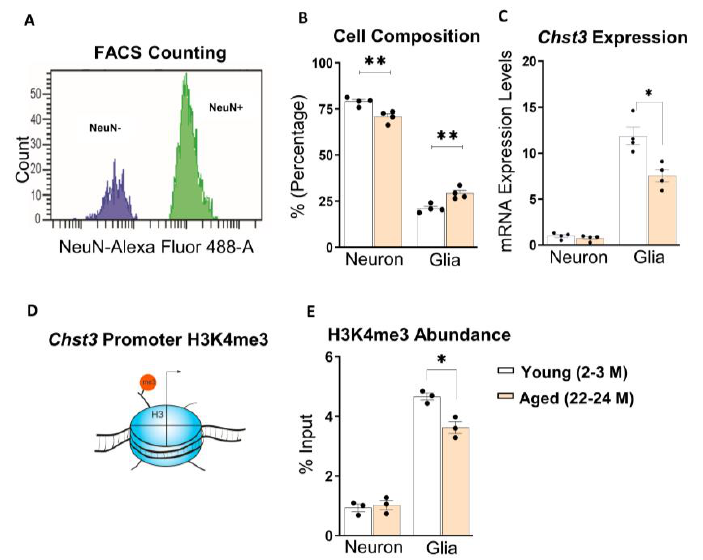
Figure 5. H3K4me3 is mostly enriched at the glial Chst3 promoter in the hippocampus of 22-24 M-old mice. Changes in Chst3 gene expression during aging were investigated specifically at the Chst3 promoter in NeuN − positive and negative cells, which corresponds to neuronal and glial cells, respectively, in the hippocampus of 22-24 M-old mice and 2-3 M-old mice. ( A ) Representative neuronal and glial nuclei amounts were quantified and the cell composition for each study group was determined using FACS techniques with neuron-specific NeuN-antibody conjugated to Alexa Flour 488. ( B ) Thus, percentages of neurons and non-neuronal cells (predominantly glia) within test groups were compared. ( C ) No significant difference was observed in cell type-specific nuclear RNA-qPCR for the expression of C6 sulfotransferase Chst3 in neurons, which was, however, downregulated in glia of 22-24 M-old mice. ( D ) Gene activation epigenetic mark, H3K4me3 at the Chst3 promoter was investigated. ( E ) A statistical summary showing that using cell type-specific ChIP-qPCR, H3K4me3 abundance at Chst3 promoter in neurons was found to be not different between 2-3 M-old mice and 22-24 M-old mice, whereas H3K4me3 was significantly less associated with Chst3 promoter in glia of 22-24 M-old mice. Bar graphs show mean ± SEM values. * p < 0.05 and ** p < 0.01, represent significant differences between 2-3 M-old mice ( n = 4 and 3 pairs) and 22-24 M-old mice ( n = 4 and 3 pairs) for cell composition/ Chst3 expression and H3K4me3 abundance,